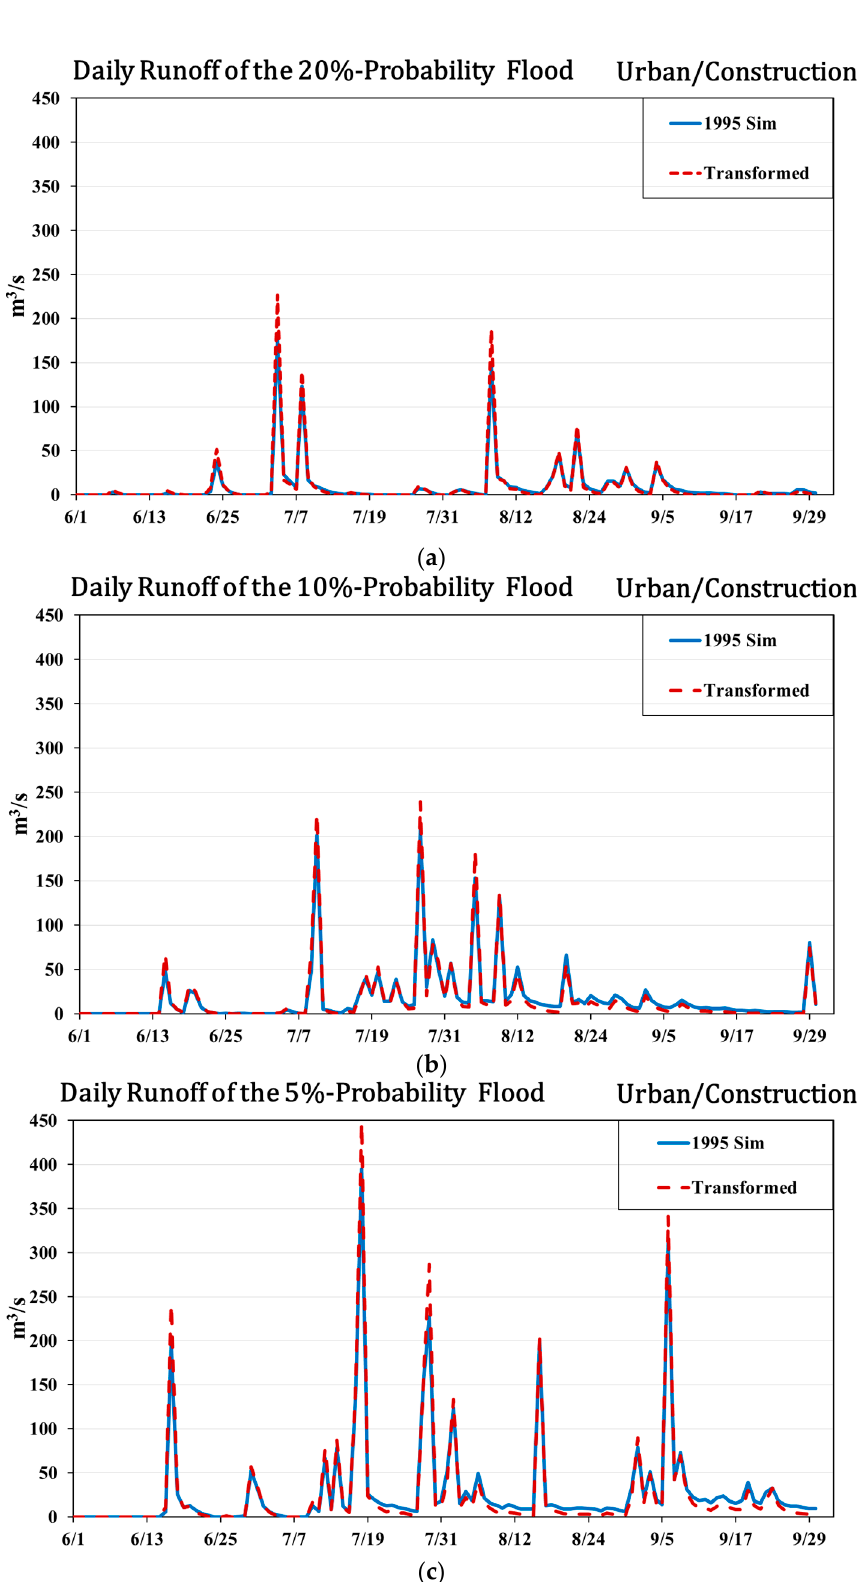
Figure 7. In every panel, the original is the result under the 1995 land use simulated by SWAT model, the transformed is the result under the S3 scenario. ( a ) The comparison of daily runoff processes of the 20% ‐ probability flood; ( b ) The comparison of daily runoff processes of the 10% ‐ probability flood; ( c ) The comparison of daily runoff processes of the 5% ‐ probability flood.